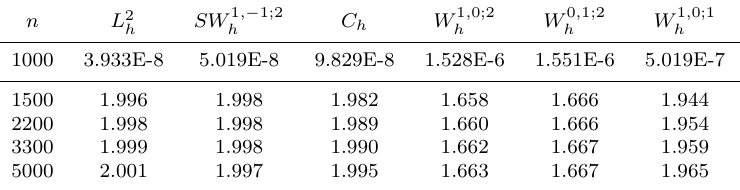
Table 13. Practical errors and error orders in Example B 5 /